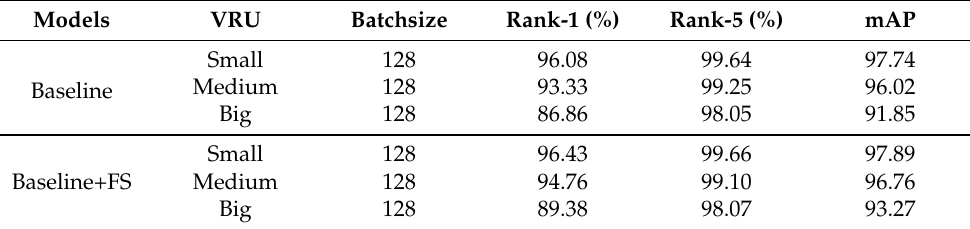
Table A8. Test results of the baseline model and the full-scale model with input batch 128 on the VRU